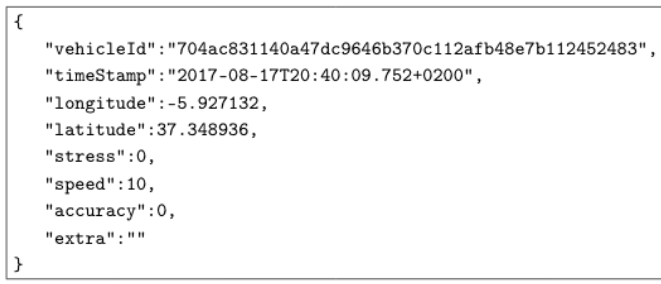
Figure 2. Minimum “Vehicle Location” JSON